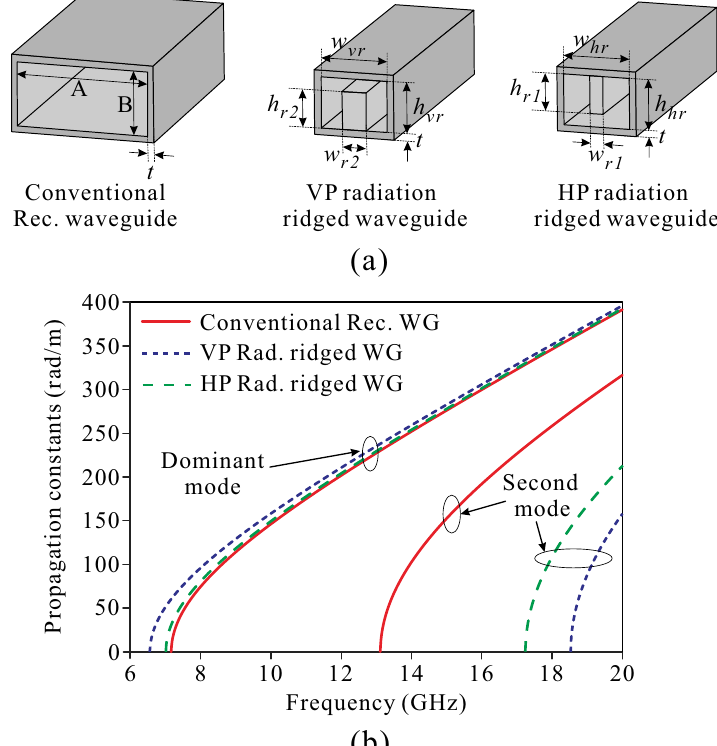
Figure 2. Comparison of three prototypes of waveguide structures. ( a ) Detailed configurations. ( b ) Propagation constant curves. (Design parameters: A = 22.86, B = 10.16, w vr = w hr = 10.008, h vr = h hr = 7.66, h vf = h hf = 7.66, h r 1 = h r 2 = 5.719, w r 1 = 2, w r 2 = 3.6, and t = 1 (units: